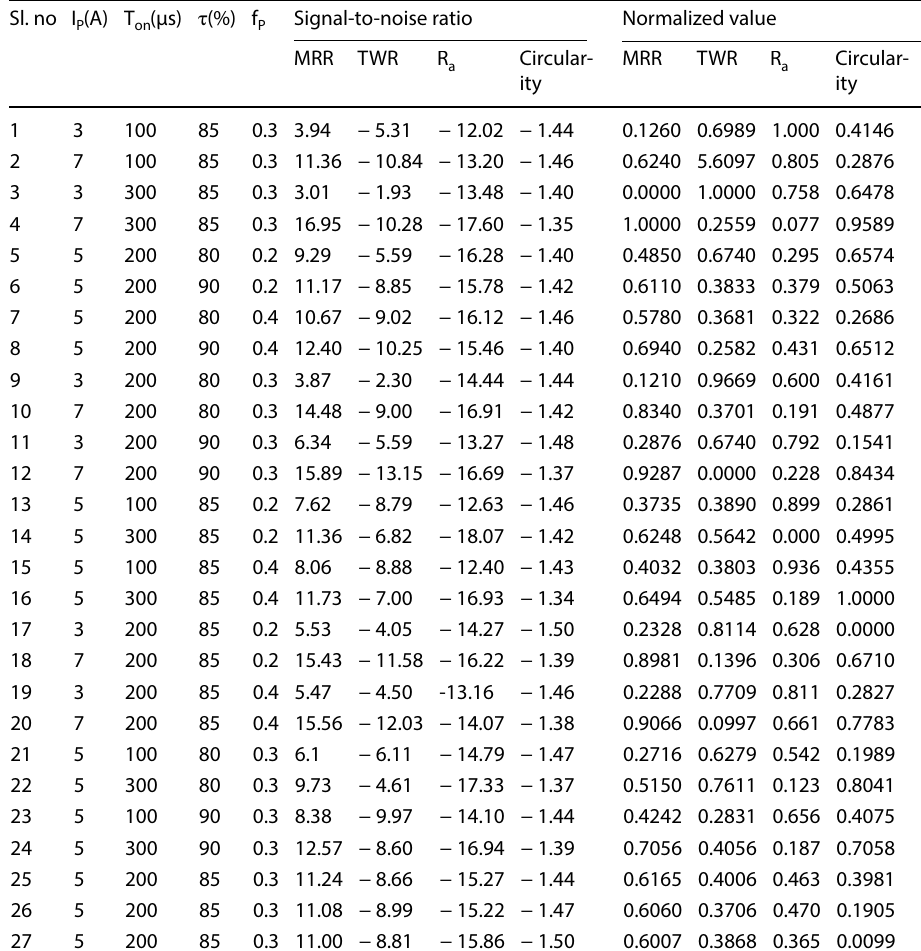
Table 3 Signal-to-noise ratio and Normalized